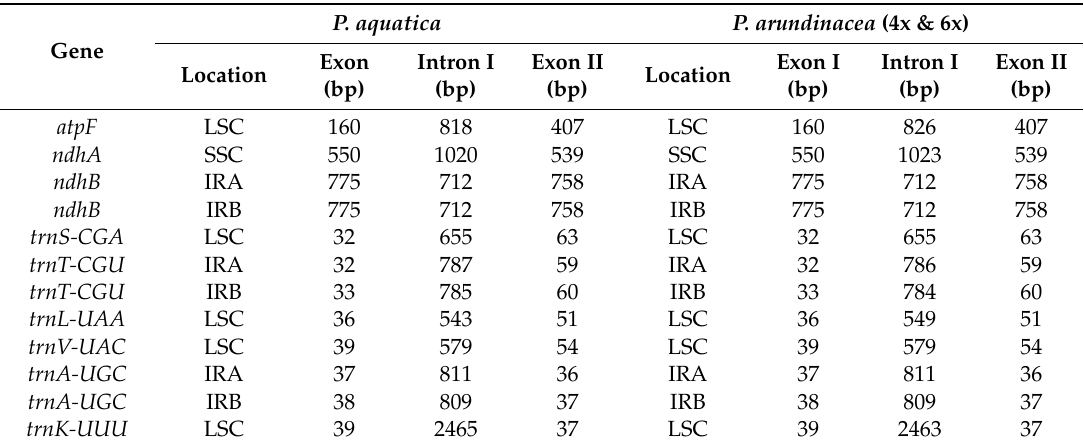
Table 3. Intron-containing genes in the three Phalaris cp